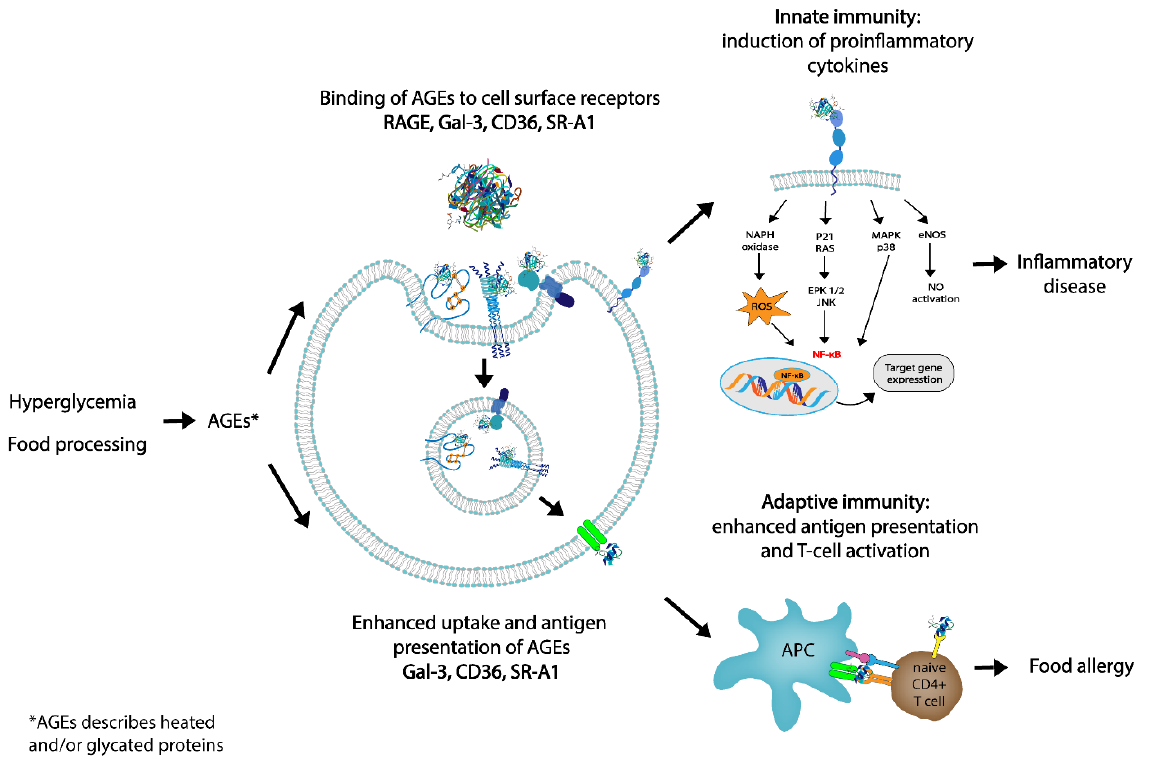
Figure 4. Role of dietary advanced glycation end products (AGEs) in innate and adaptive immunity. By targeting AGE receptors, dAGEs may influence innate immunity via interaction with RAGE or by binding to AGE receptors which internalize the ligands: galectin-3 (Gal-3), CD36, and scavenger receptor class A type I (SR-A1). Presentation of antigen to T cells may facilitate T-cell activation and skewing, possibly leading to allergic responses. In this way, dAGEs may contribute to both innate and adaptive immunity.